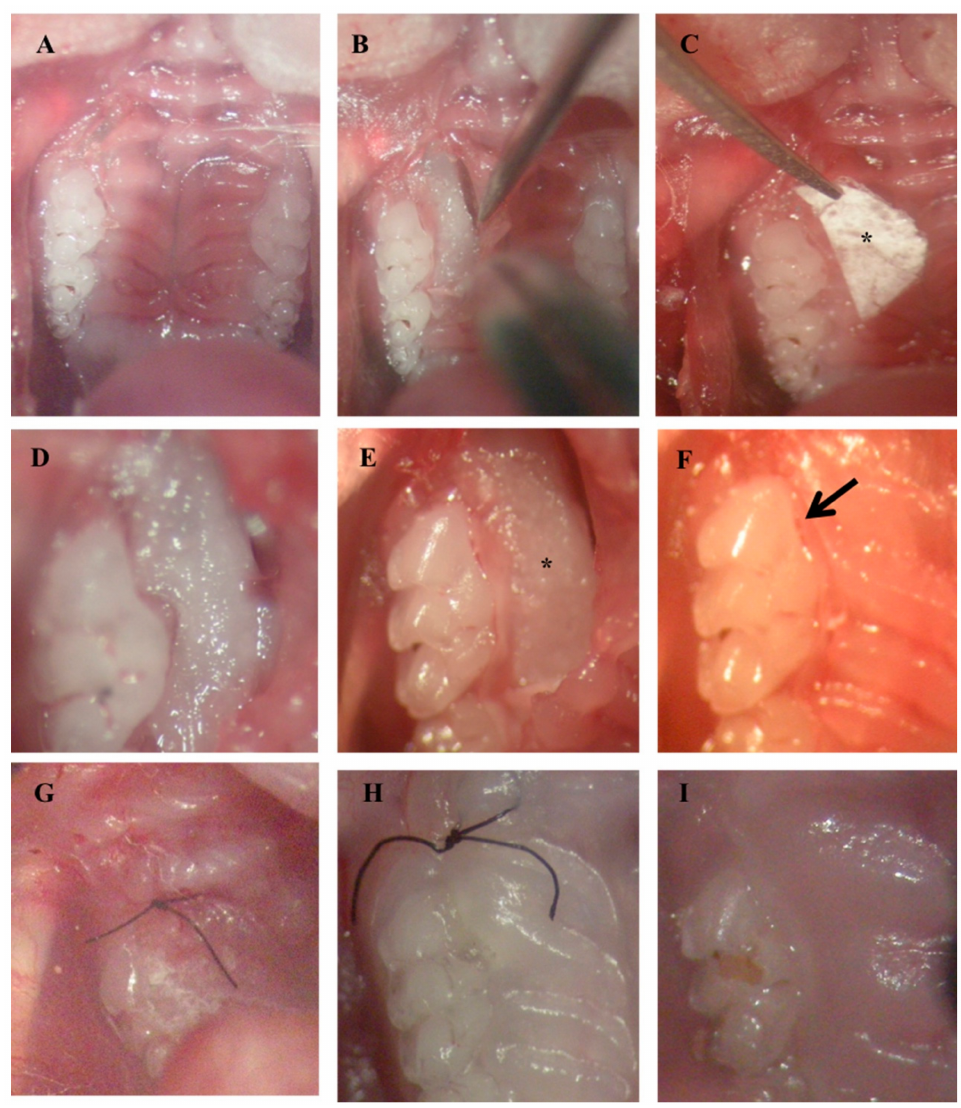
Figure 7. Surgical placement of membrane in the induced periodontitis mice model. Incision ( A ) followed by flap raising for periodontal lesion access and debridement ( B , D ). Membrane (*) calibration ( C ) and placement (*) beneath the palatal flap ( E ). Palatal flap covering membrane (arrow) ( F ). Sutures ( G ). Post-surgical views at 7 days ( H ) and 15 days ( I